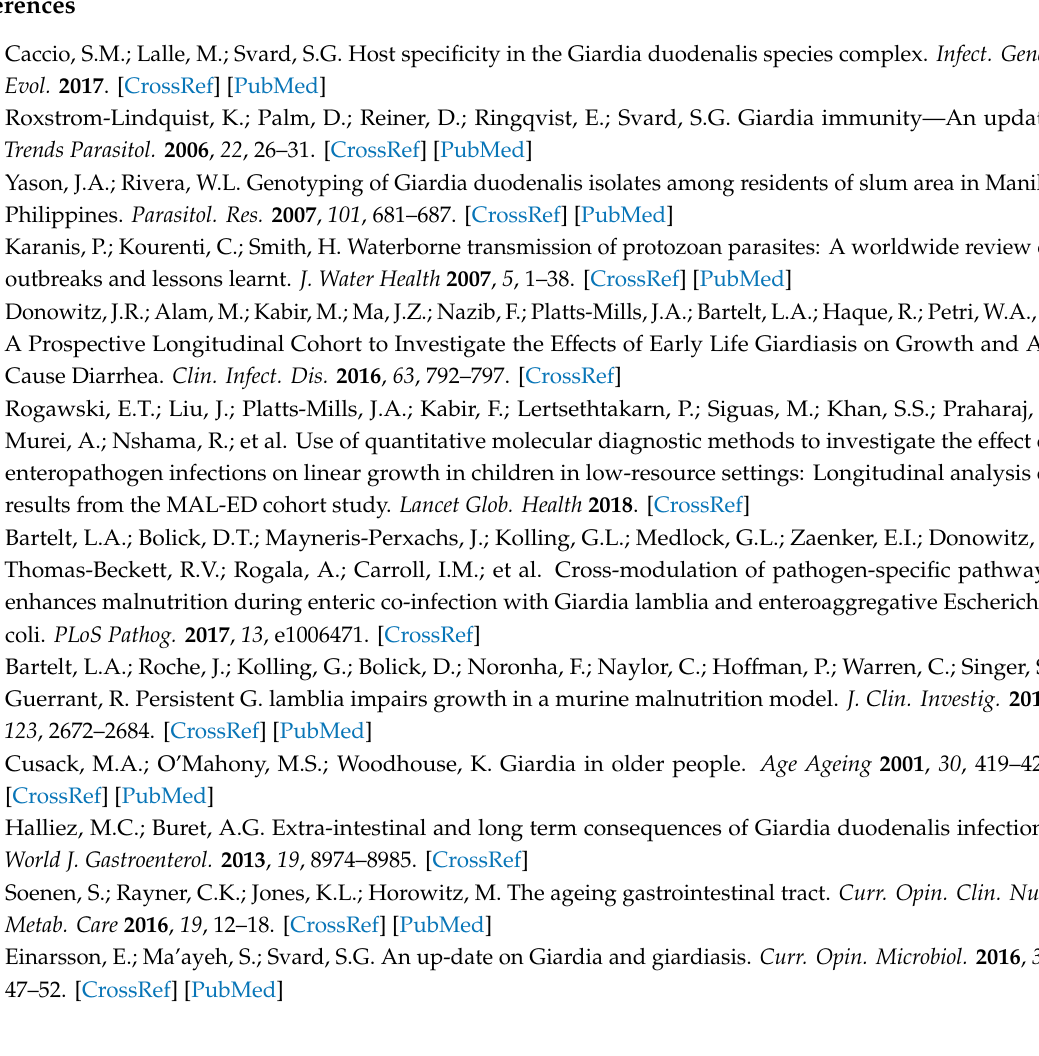
Figure S1: Weight changes in infected young mMCP-4 +/+ and mMCP-4 − / − mice; Figure S2: Identification of Giardia by nested PCR in fecal and intestinal